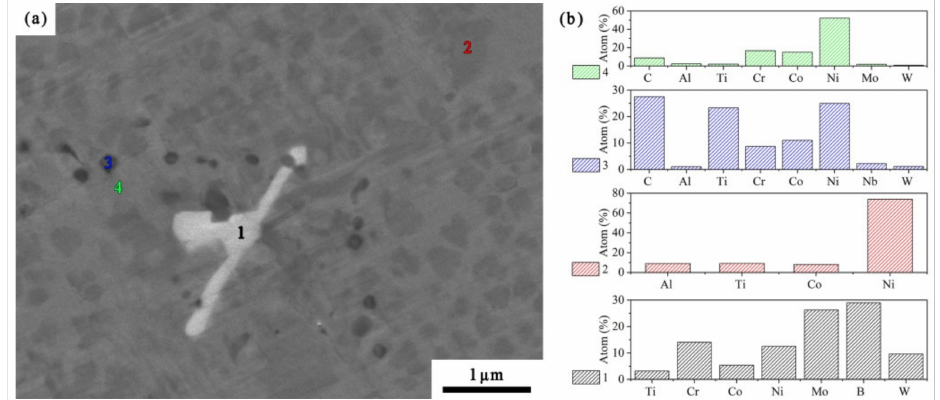
Figure 5. ( a ) BSE image of the 1200 ◦ C-HP sample; ( b ) EDS